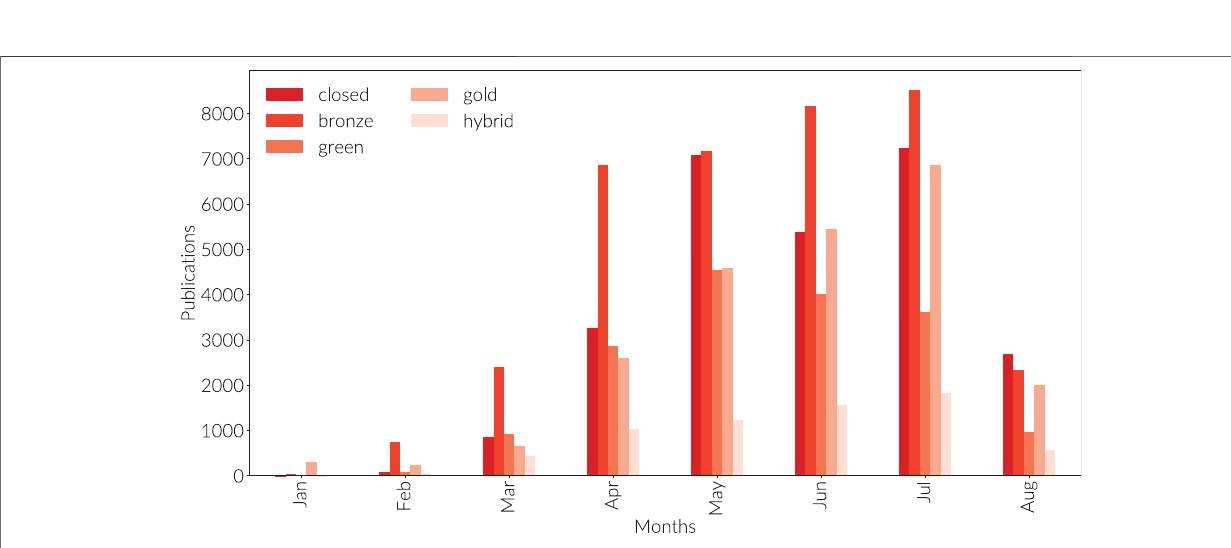
Frontiers in Research Metrics and Analytics |